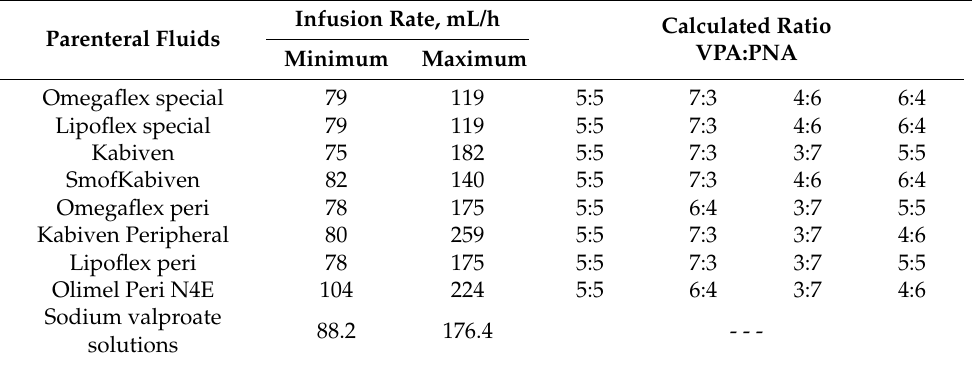
Table 2. The calculated volume ratio between drug solutions and